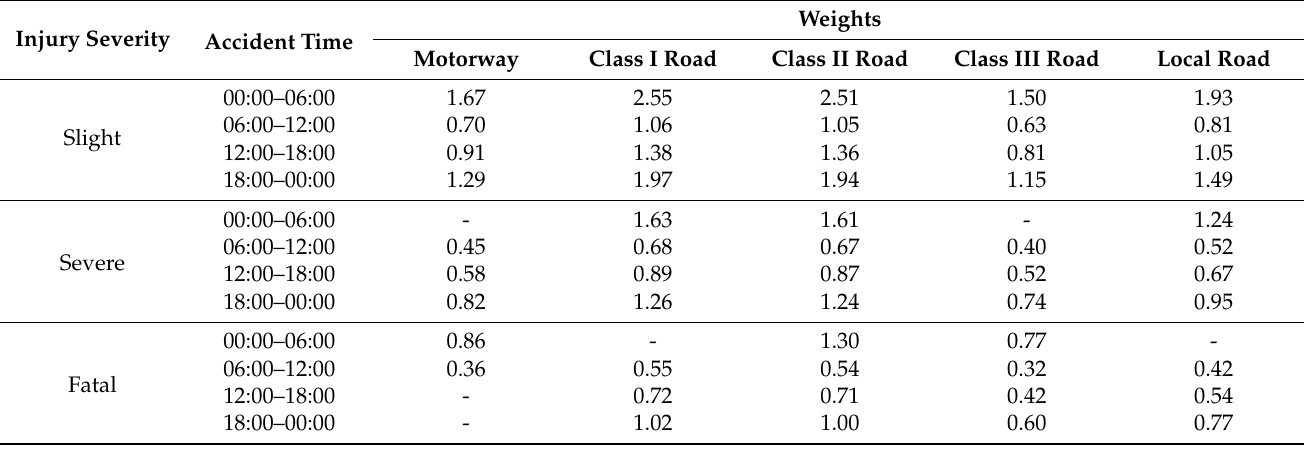
Table 1. The resulting vector of weights for every cross-classification term.